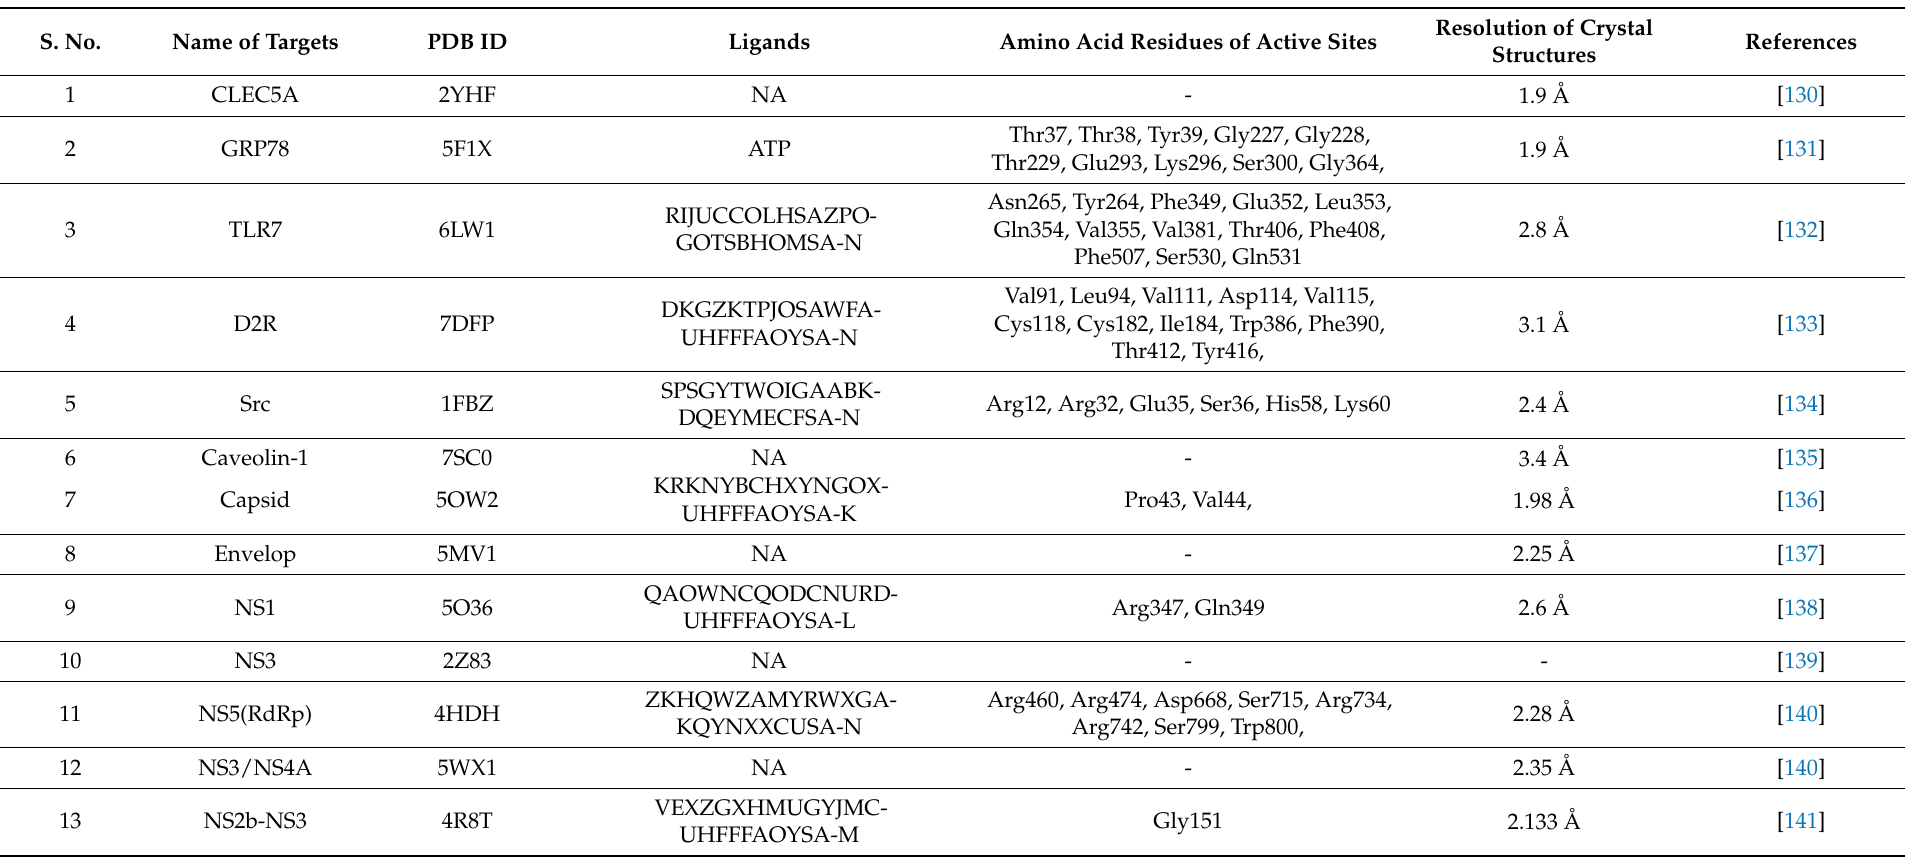
Table 3. In vitro, in vivo, and in silico targets for inhibiting JEV infection, targeting replication, host binding, autoimmunity, and cytokine generation, together with their active pocket residues and native ligands from crystal